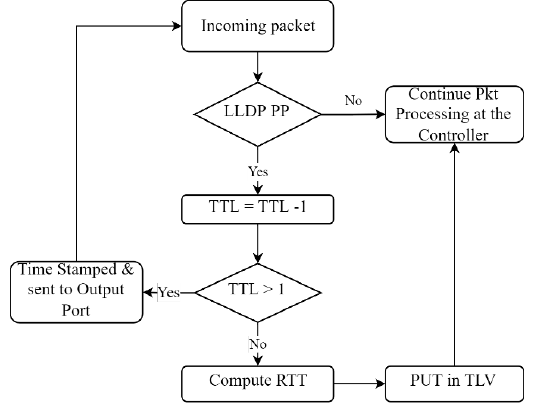
Figure 4. LLDP Looping